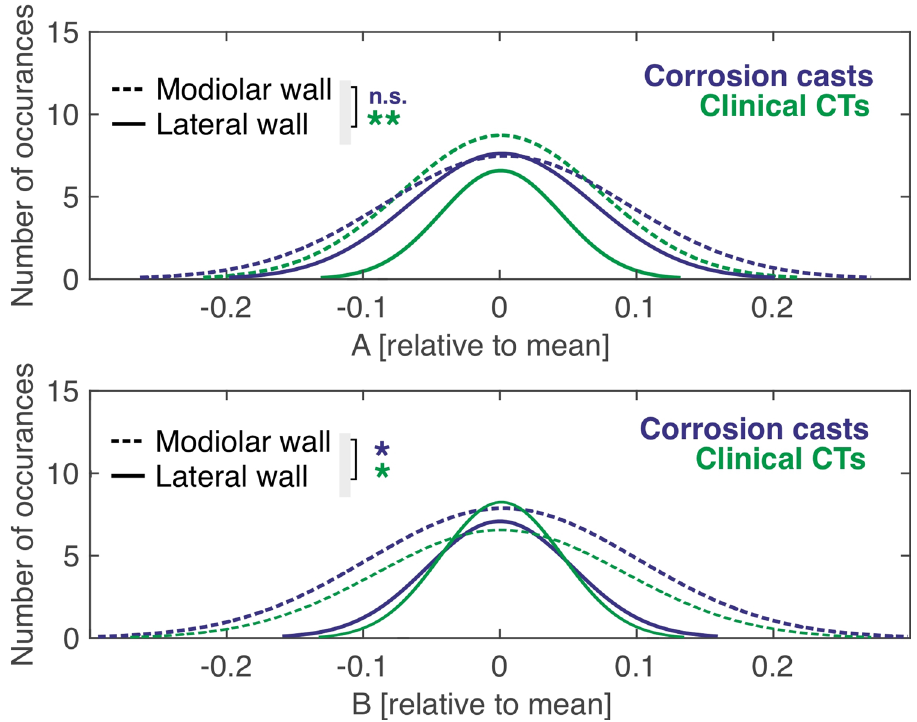
Figure 5. Comparison of the variance of lateral wall and modiolar wall measures after subtracting the mean and normalizing to the mean. *p < 0.05; **p < 0.01; n.s. not significant p > 0.05.